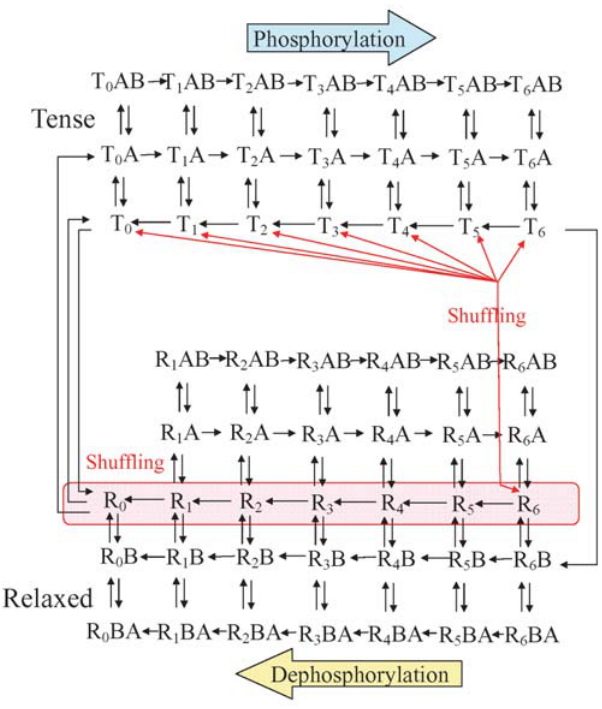
Figure 1. Reaction scheme assumed in the model. Association/ dissociation, kinase/phosphatase reactions, and allosteric transitions are indicated by black arrows. Monomers of KaiC can be shuffled between T and R 6 (red arrows) and between two Rs (pink area).